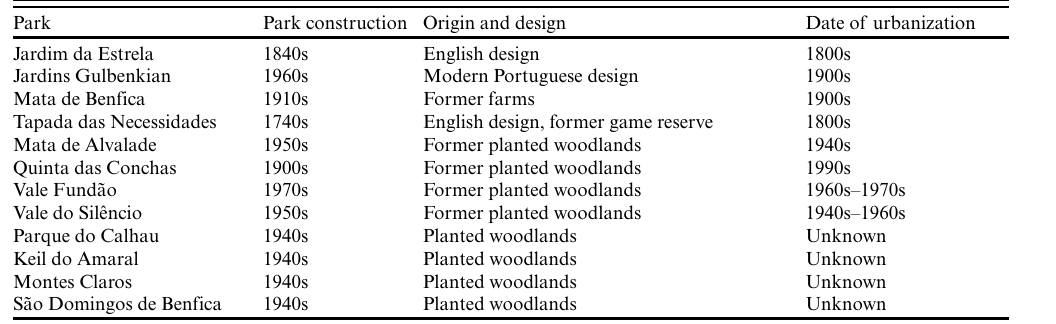
Table 1. List of park characteristics, including age, origin, and